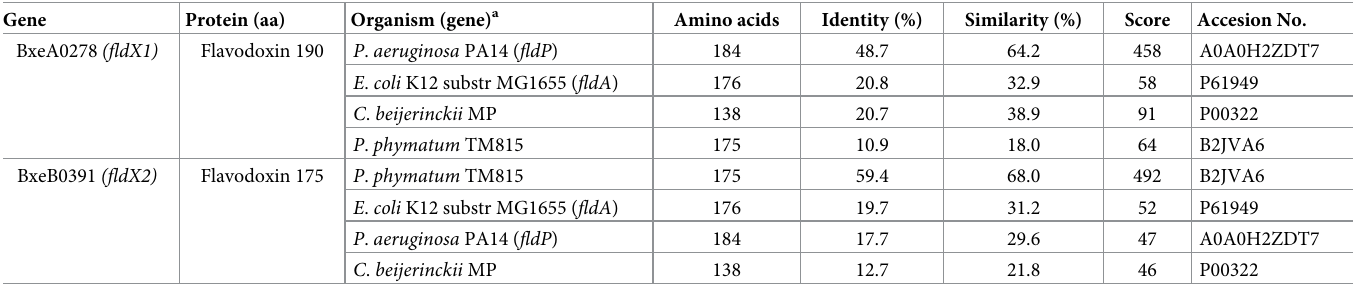
Table 2. Comparison of flavodoxins identified in P . xenovorans LB400 genome with long-chain and short-chain flavodoxins. Gene Protein